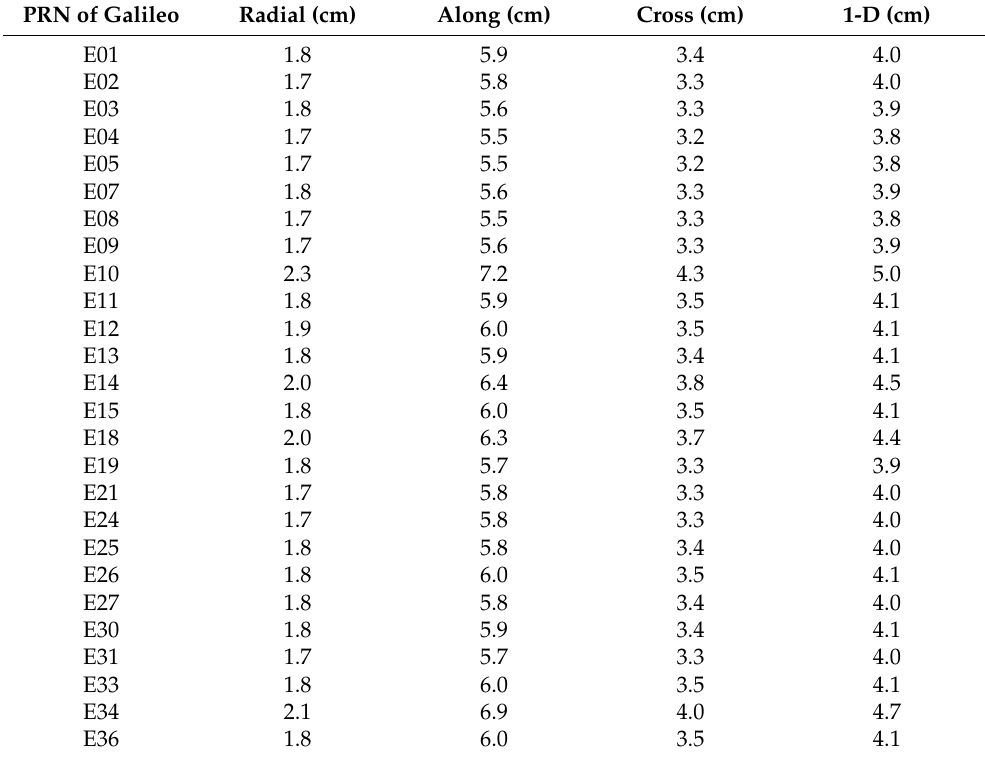
Table 7. Mean RMS value of Galileo satellites in comparison with GFZ final orbit.